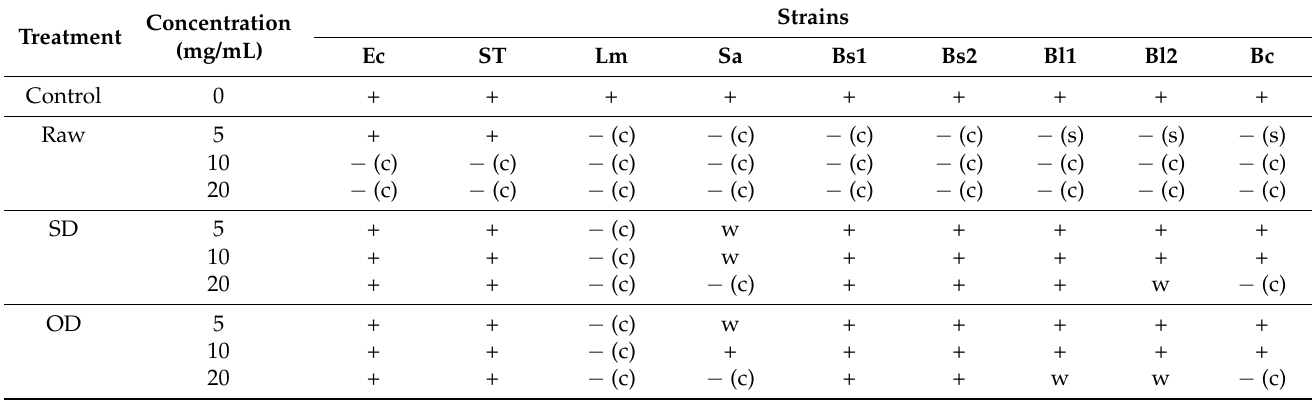
Table 1. Effect of raw dried oregano (raw) and oregano residues obtained from distillation followed by sun-drying (SD) or oven-drying (OD) treatment on the growth 1 of E. coli (Ec), S. Typhimurium (ST), L. monocytogenes (Lm), S. aureus (Sa), B. subtilis (Bs1, Bs2), B. licheniformis (Bl1, Bl2), and B. cereus (Bc) strains. When no growth occurred, the mode of action 2 on cell viability was also recorded.